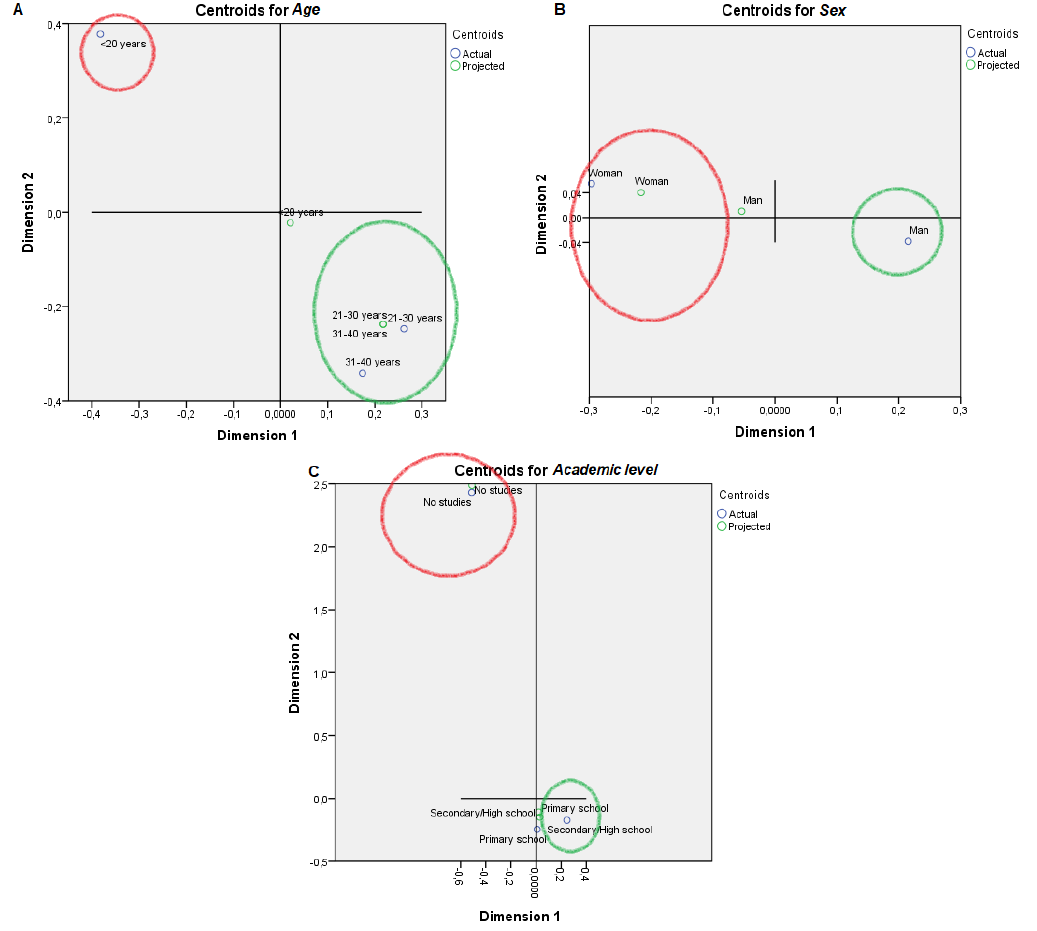
Figure 6. Object scores plot visualization of Professional Customer Profiles with regards professional characterization, egg consumption non-affine professional profile or PPA (red), and affine profile or PPB (green). Professional characterization was determined through: ( A ) Age, ( B ) Sex and ( C ) Academic level.